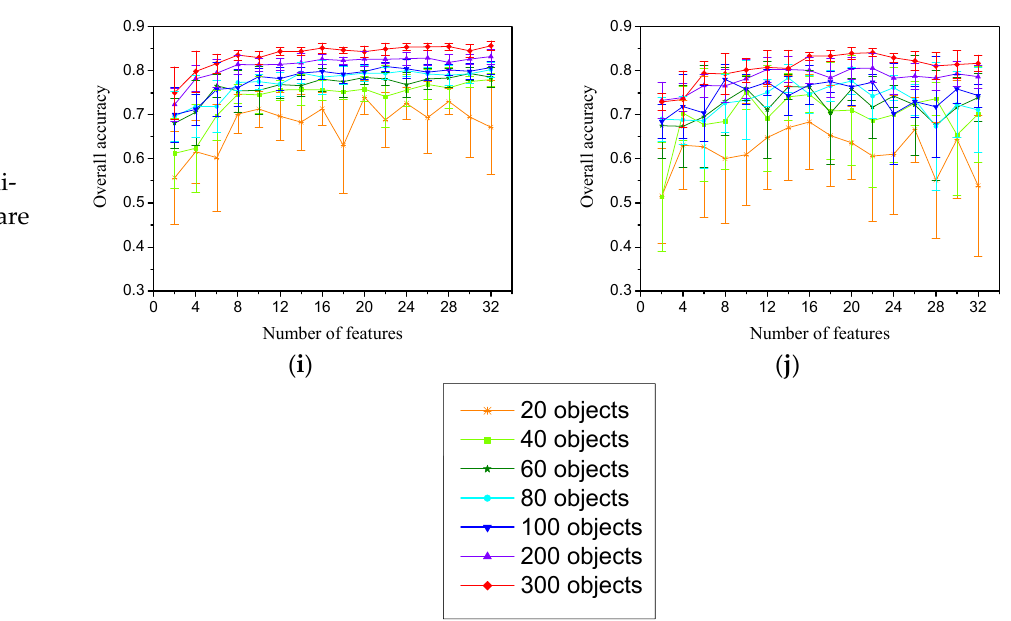
Figure 3. For area 2, the relationship between the mean overall accuracy of classifications repeated ten times (fixed numbers of features and training set size) and the number of features using five feature-importance-evaluation methods with different training set sizes for both classifiers. Table 2. Summary of the test for the differences between the classifications with feature subsets following an ascending order and that derived from the full feature set. The statistical value was derived from a two-tailed t -test. The difference is significant at the 0.05 significance level if the absolute value of the test statistics is greater than 1.96. The positive number indicates that the mean accuracy of the full feature set was better than that derived from the selected subset, otherwise the subset was better.